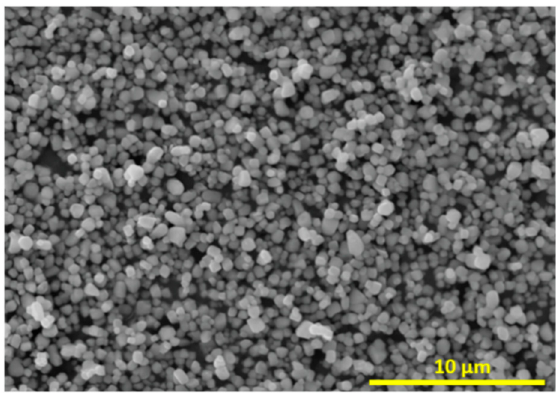
Figure 13. SEM observation of the BaTiO 3 nanoparticles.